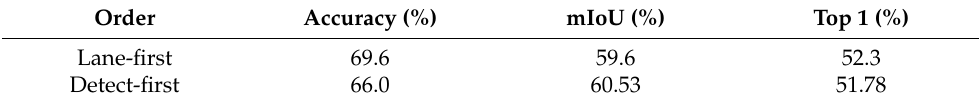
Table 6. Comparison of order with lane line detection head first or target detection head